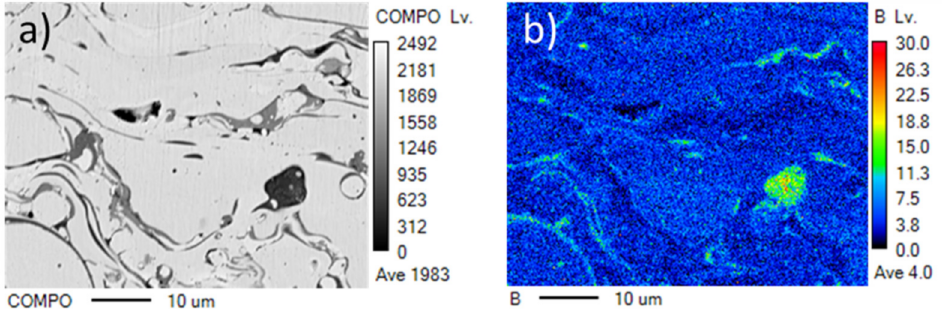
Figure 3. EPMA mapping of boron of the as-sprayed NiCrB-Air coating. ( a ) images of cross-sections of coating, ( b ) EPMA mapping of